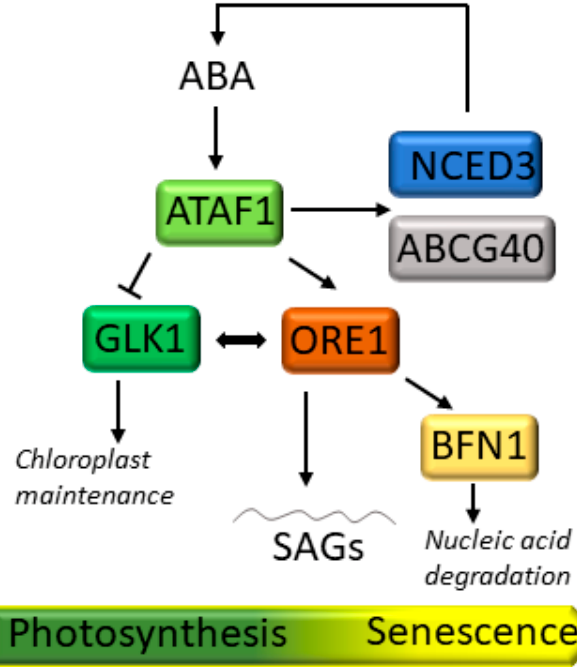
Figure 4. Schematic model highlighting ACTIVATING FACTOR1 (ATAF1) regulatory network during senescence. ATAF1 activates ORESARA1 (ORE1) and represses GOLDEN-LIKE1 (GLK1) expression by directly binding to the promoters of both genes. ORE1 directly interacts with GLK1, which is involved in the proper development and maintenance of chloroplasts. During senescence progression, the expression of GLK target genes is impaired, while the expression of ORE1 target genes is enhanced, promoting developmental senescence and programed cell death through a gene regulatory network that involves BIFUNCTIONAL NUCLEASE1 (BFN1) and other direct target genes, including di ff erent SAGs. BFN1 plays a role in nucleic acid degradation. Besides, ATAF1 also elevates the ABA levels by directly interacting with the ABA biosynthetic gene NCED3 , encoding 9- cis -epoxycarotenoid dioxygenase 3, and the ABA transporter